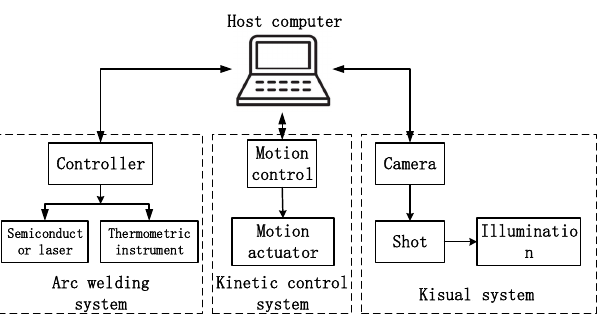
Figure 3. Overall frame diagram of the system.